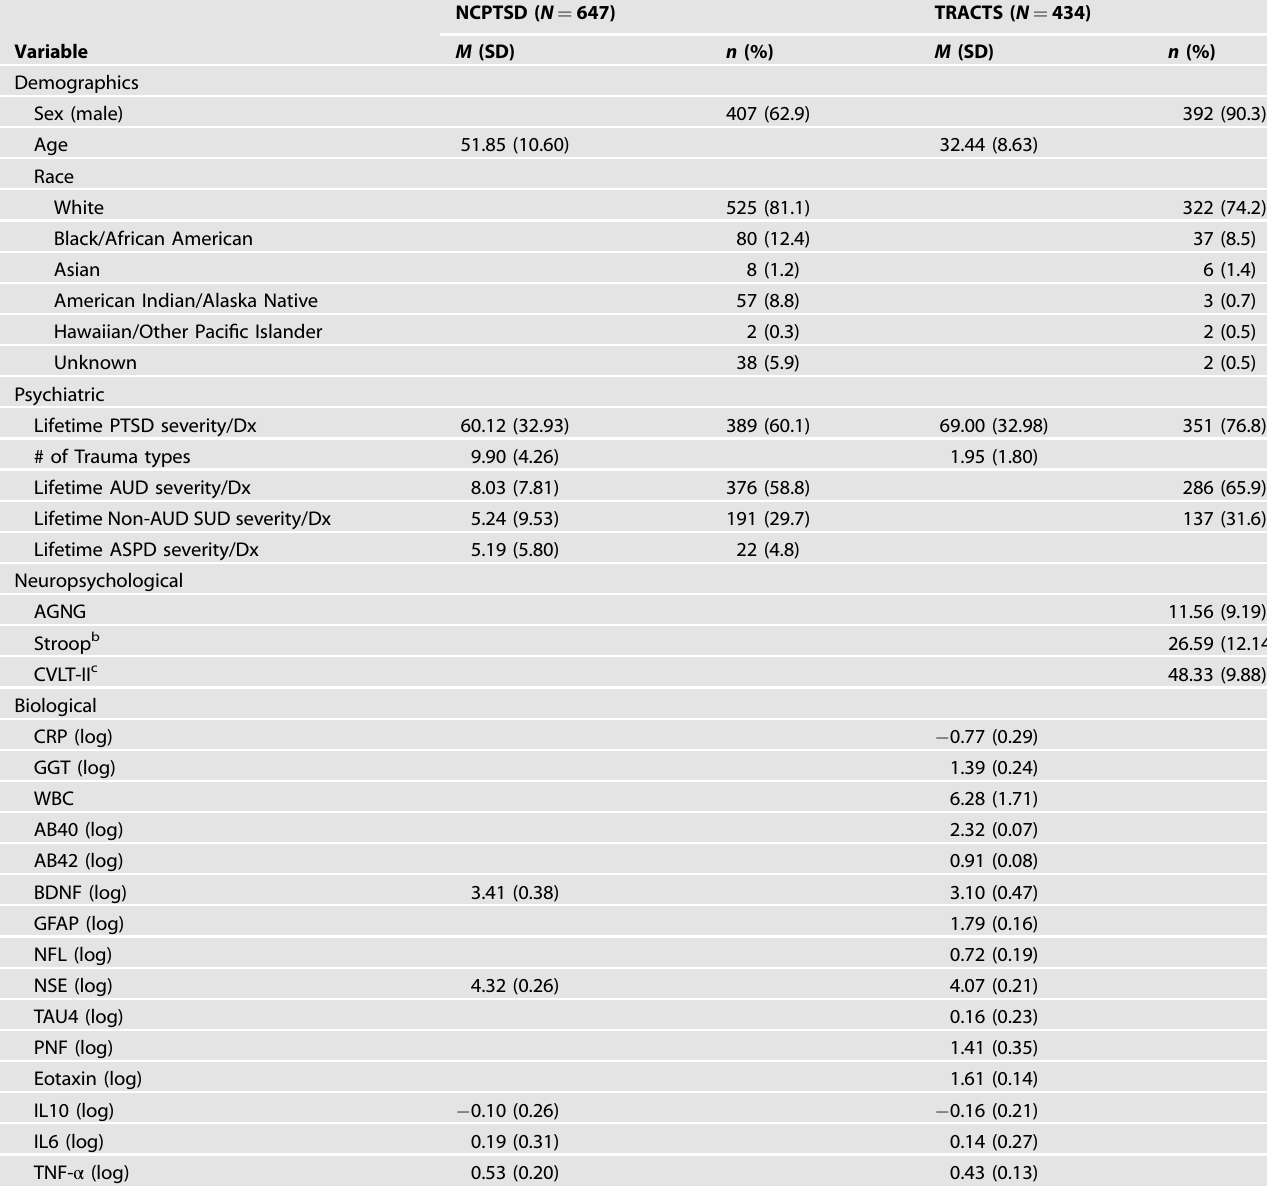
Table 1. Participant characteristics and descriptive